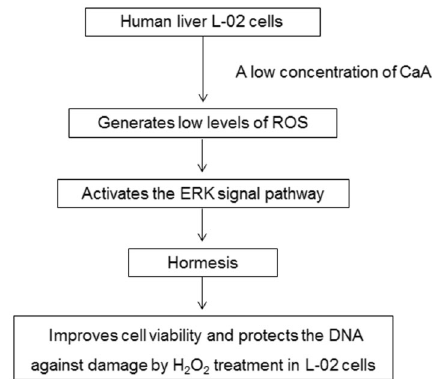
Figure 7. Caffeic acid (CaA)-induced improvement of cell viability and protection against DNA damage: involvement of reactive oxygen species (ROS) and extracellular signal-regulated kinase (ERK)